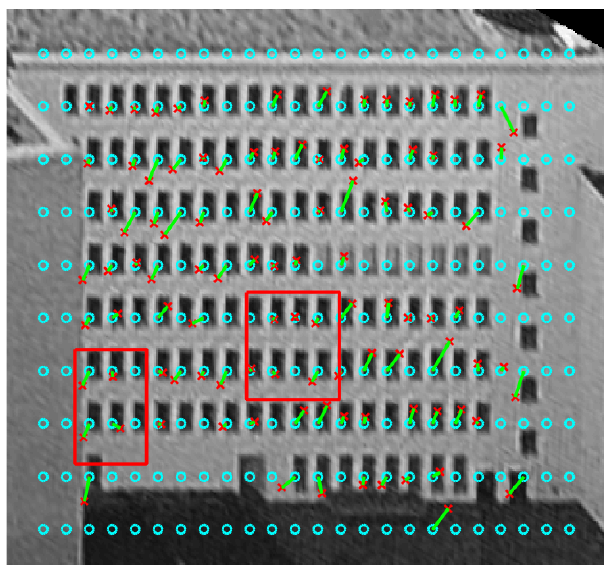
Figure 6: Overview of the facade ’Lindenstraße’. Red crosses: Persistent Scatterers projected into the image. Cyan circles: Final lattice nodes after convergence. Green lines: matching vectors between PS and corresponding lattice nodes. Two areas marked with red rectangles are used for further investigations.